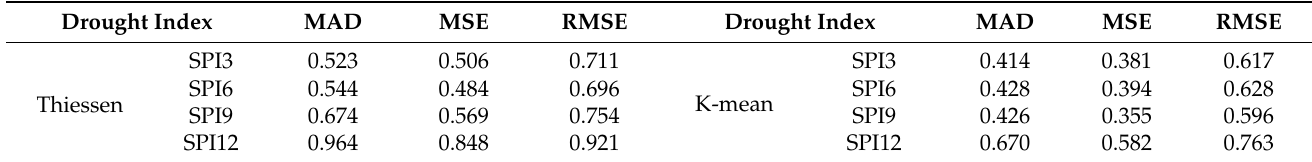
Table 5. SPI and accuracy analyses using the Thiessen method and cluster analysis for drought damage. Drought